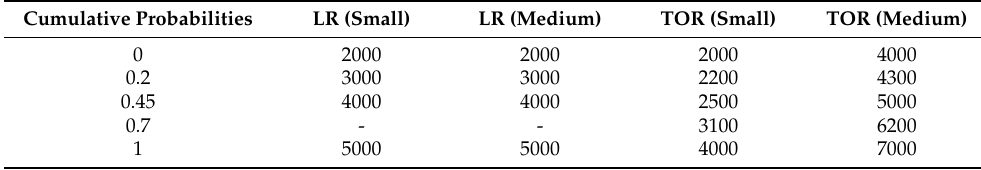
Table 4. LR and TOR distances (feet) and probabilities [42].